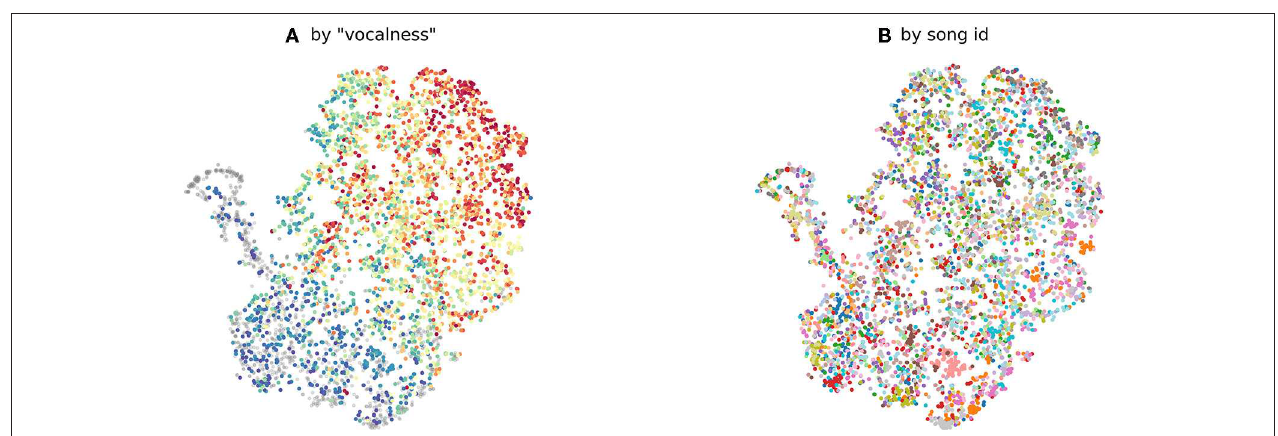
FIGURE 14 | 2-dimensional scatter plot using t-SNE. Each point represents 2-second audio mixture signal chunks that are encoded by a VS-specialized encoder. (A) the color map of points is based on the loudness of the isolated vocal signal for a given mixture signal. The red color indicates higher loudness, and the blue color indicates smaller loudness. (B) the same chunks are colored by the song each chunk belongs to. The samples are randomly sampled from the MUSDB18